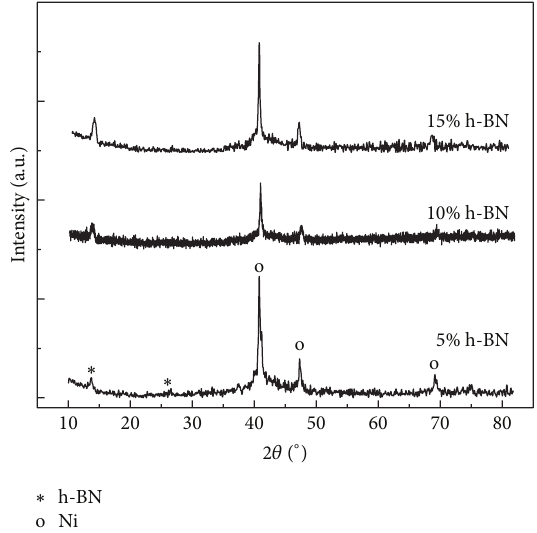
Figure 6: XRD patterns of the Ni45-h-BN composite coating.